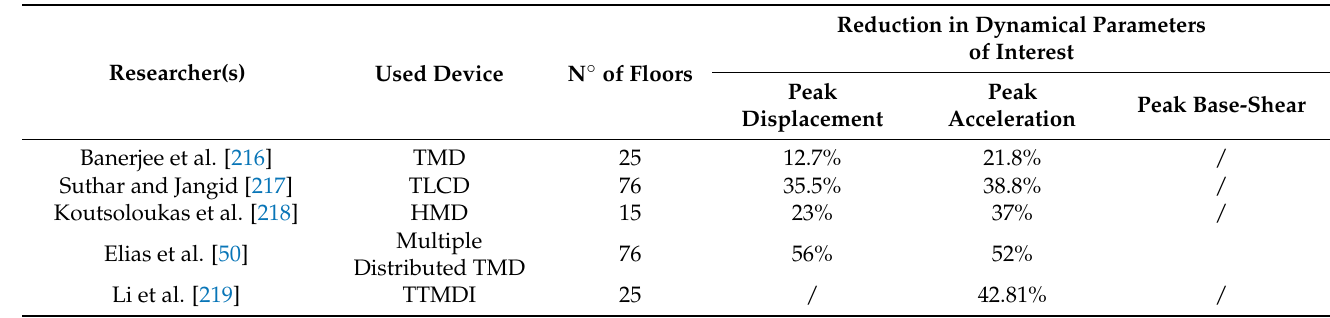
Table 2. Performance of various control strategies for reducing wind-induced vibrations in high- rise